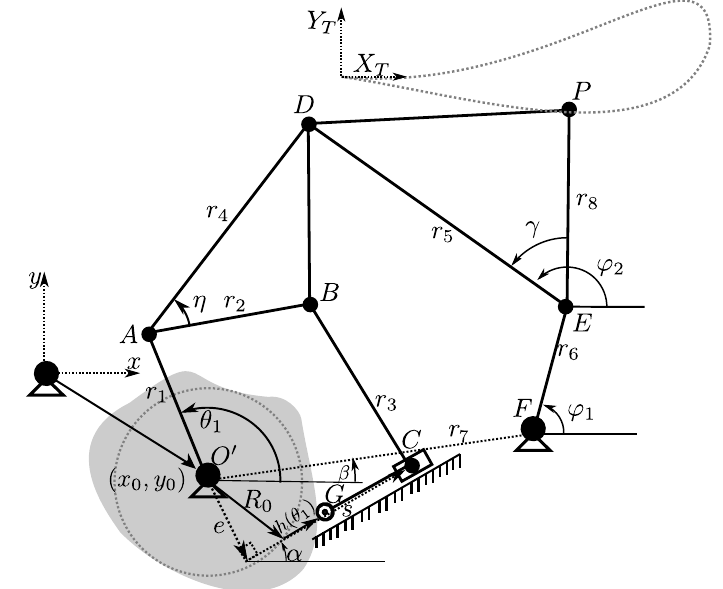
Figure 5. cam–linkage